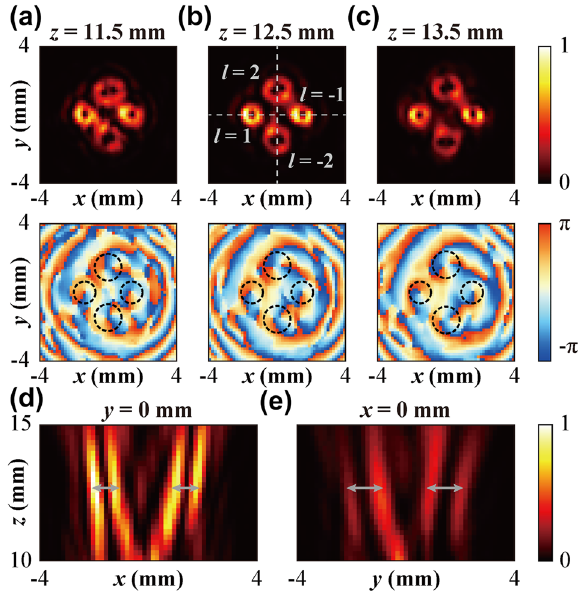
Figure 4: Four-channel focused vortex beams generation with different topological charges ( l = 1, − 1, 2, − 2) (a–c) measured electric field intensity and phase distribution of the generated vortex beams at three different x – y planes. (d) and (e) measured electric field intensities at the y = 0 mm and x = 0 mm